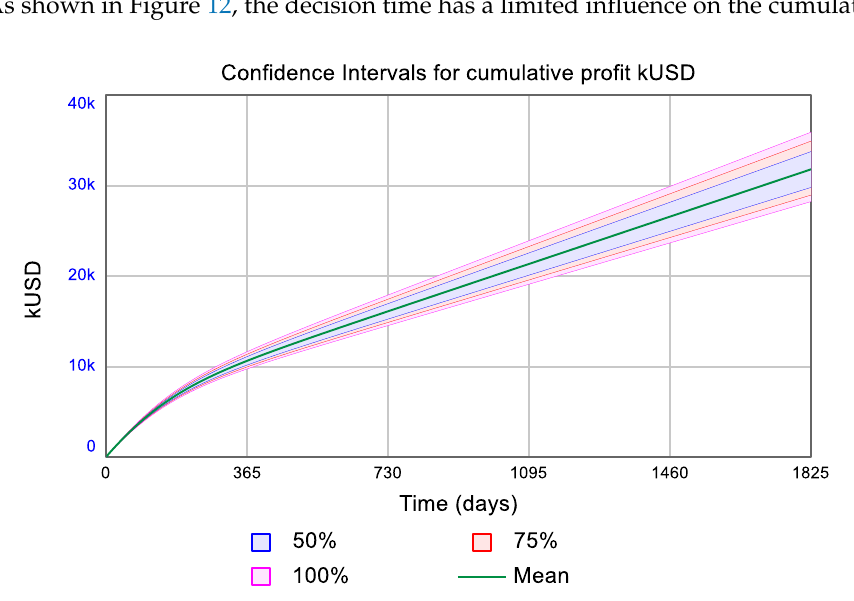
Figure 11. Cumulative profit over five years (1825 days) for different values of the extra times for repair, replacement, and maintenance. The mean value and confidence intervals are shown.